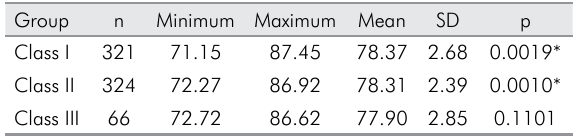
Table 3. Comparison of the anterior ratio of each group with Bolton’s ratio (77.2 ± 1.65) by independent